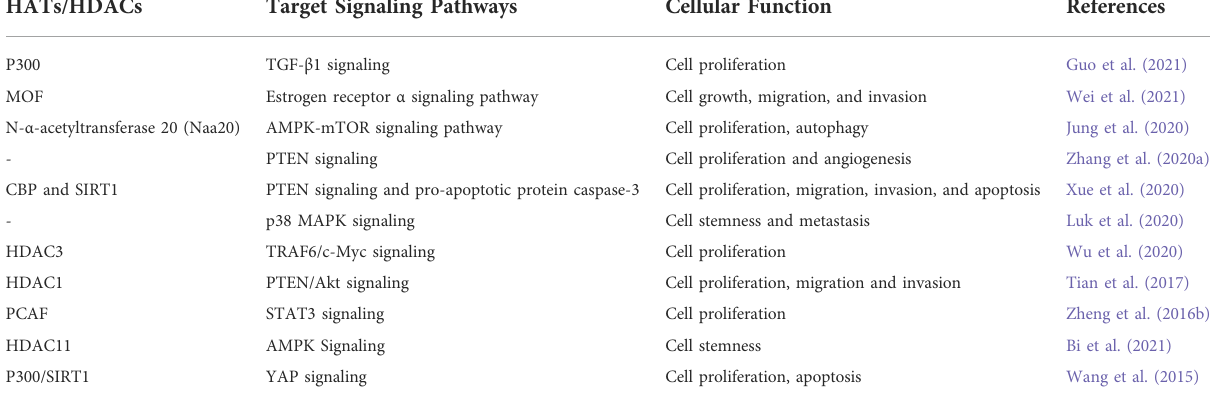
TABLE 2 The target cancer signaling pathways by acetylation modi fi cations in HCC.